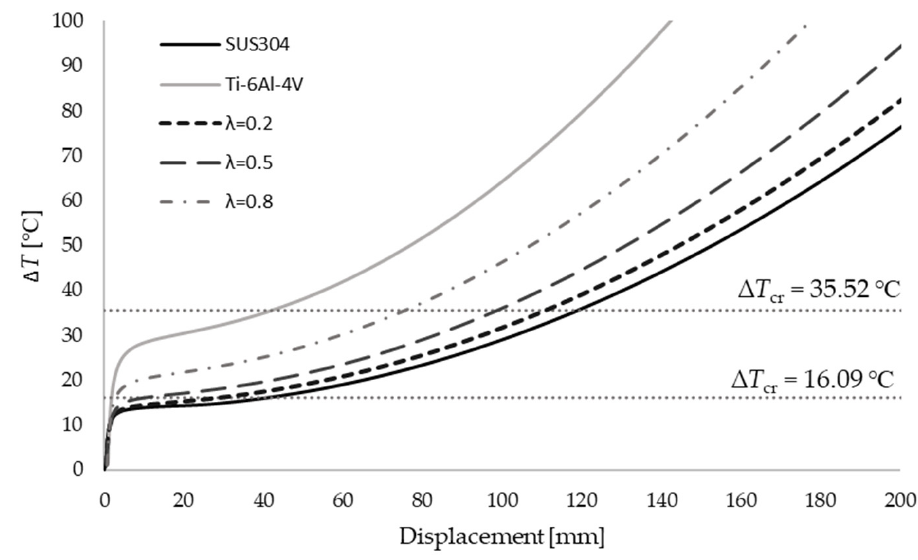
Figure 8. Displacements of the L-frame for several values of the material thickness ratio.